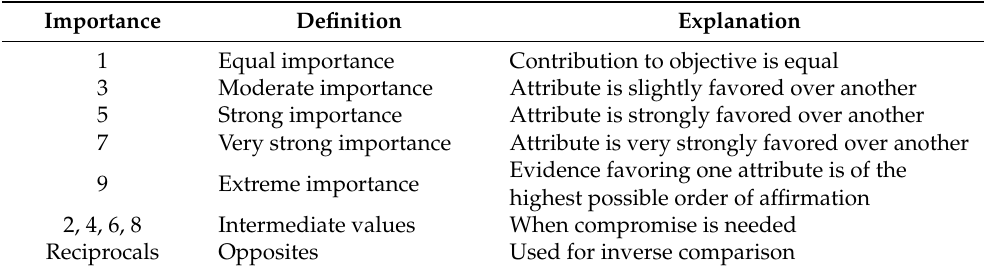
Table 3. Scales for pairwise comparisons